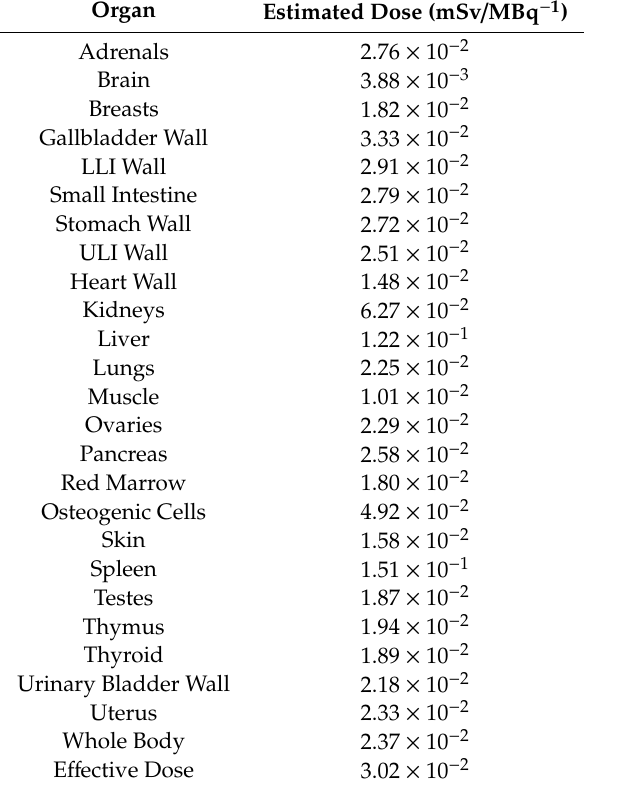
Table 2. Estimated absorption dose of 131 I-IFNABZA in a 73 kg adult